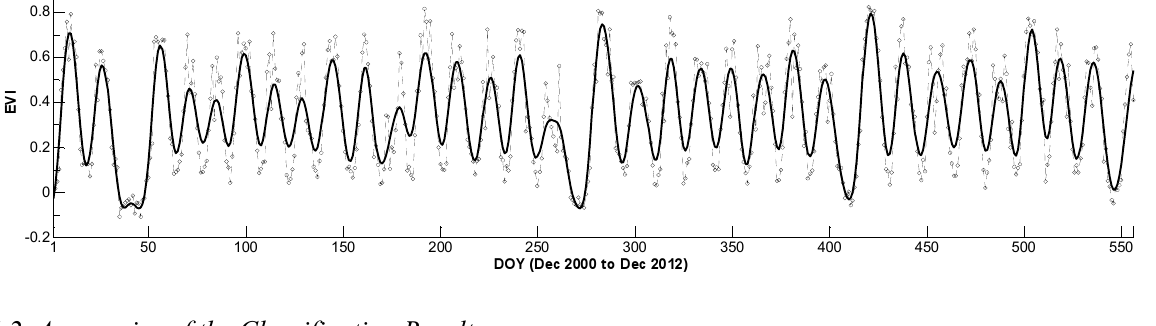
Figure 6. The raw EVI signal profile (dashed line) and the smooth profile (solid line) derived from the EMD-based low-pass filter by adding IMFs ( c for rice-cropping seasons from December, 2000, to December, 2012.